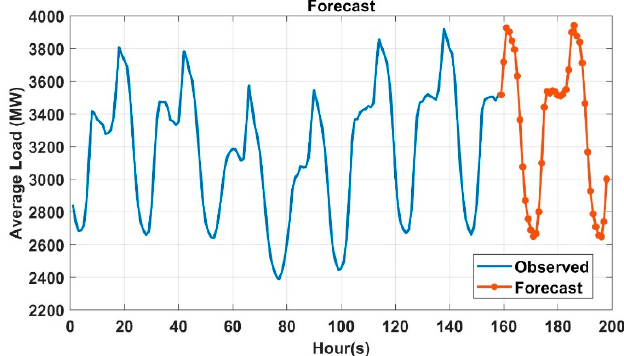
Figure 12. Per-hour forecast of future time series.